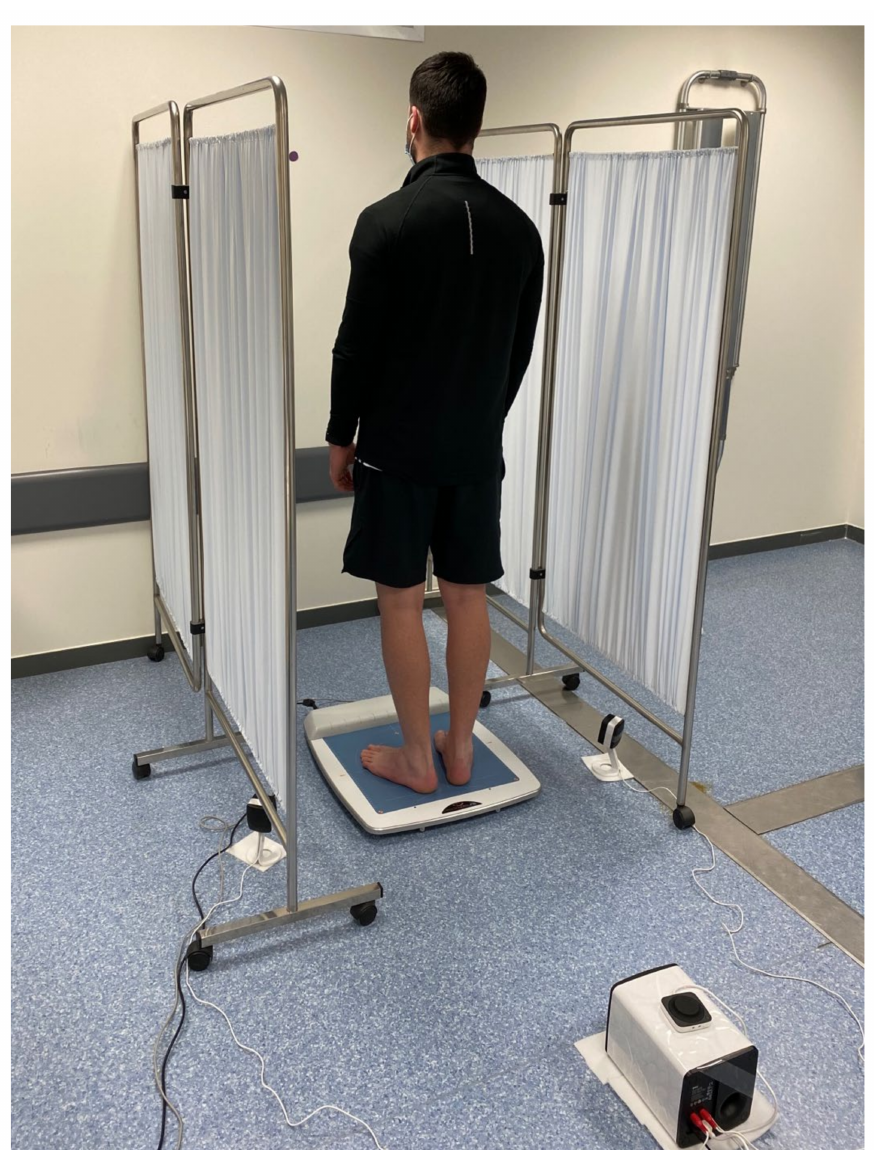
Figure 1. Participants’ stabilometric assessment and environmental